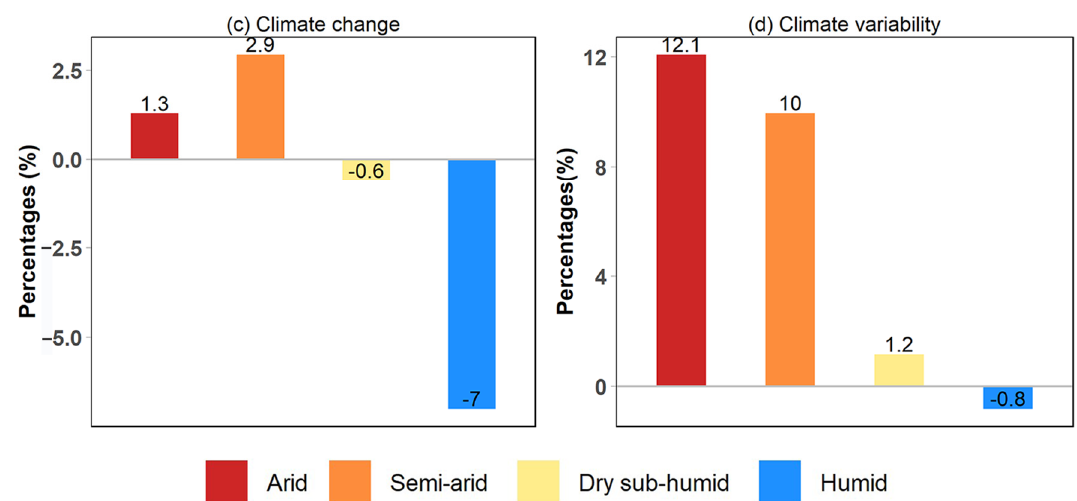
Figure 8. The relative contribution rate of ( a ) CO 2 fertilization (CO 2 ), ( b ) land use (LU), ( c ) climate